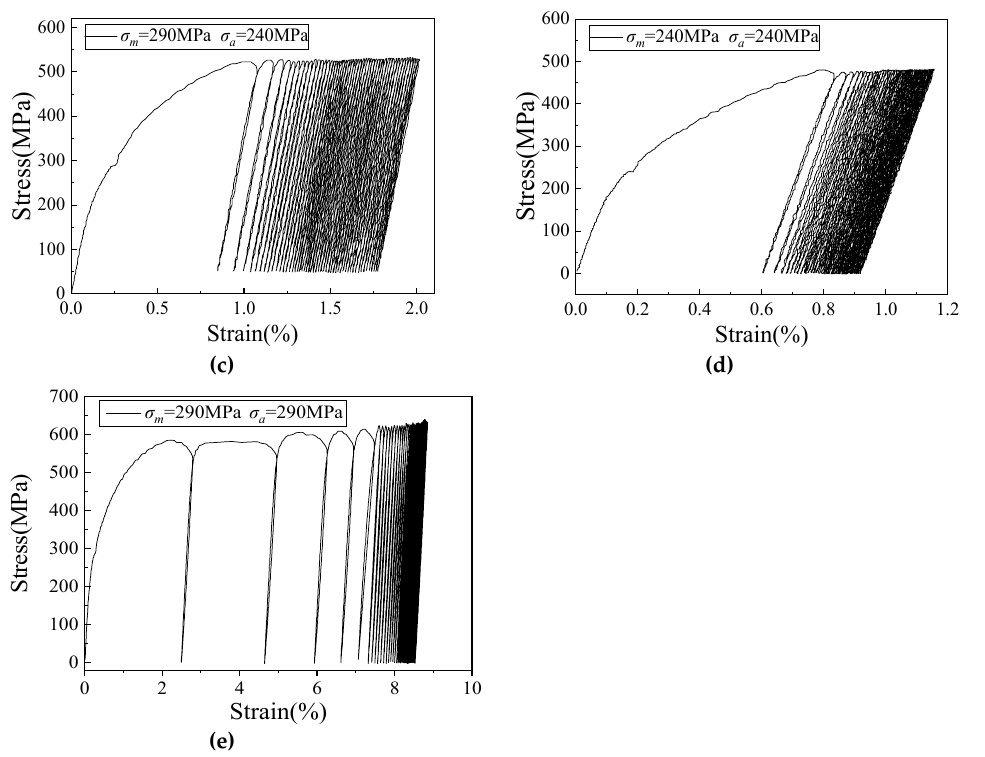
Figure 3. The stress - strain response in the first 50 cycles under different loading conditions: ( a ) σ m = 290 MPa σ a = 190 MPa ( b ) σ m = 290 MPa σ a = 215 MPa ( c ) σ m = 290 MPa σ a = 240 MPa